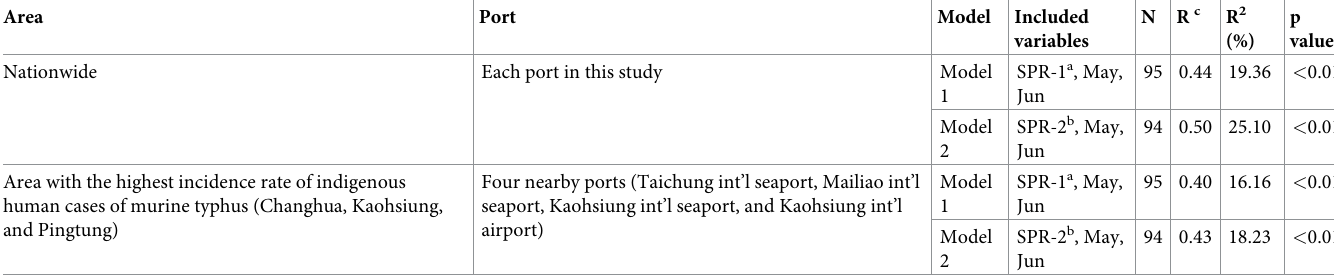
Table 2. Performance of different regression models for explaining the incidence rate of indigenous human cases of murine typhus.